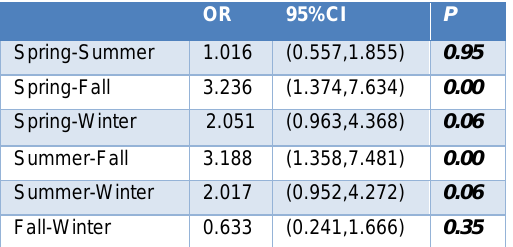
Table 3. odd ratio for prevalence of congenital